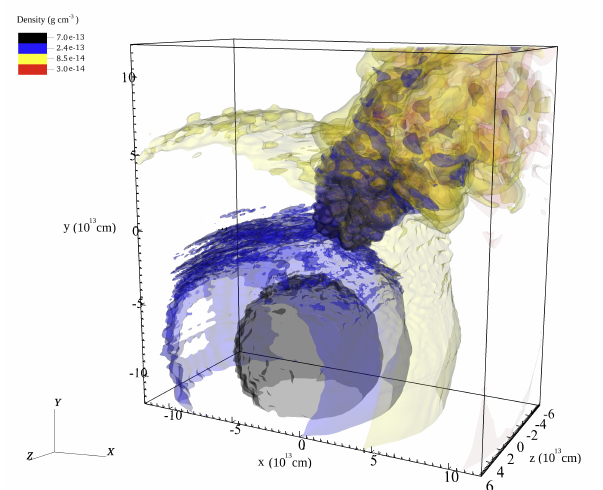
Figure 4. A 3D density contour view of Run 4, that includes orbital motion at a time after reaching a quasi-steady state, namely, after the enhanced wind of the primary reached the whole simulation volume. The upper right corner shows the trailing of the colliding winds behind the secondary (located at the centre).